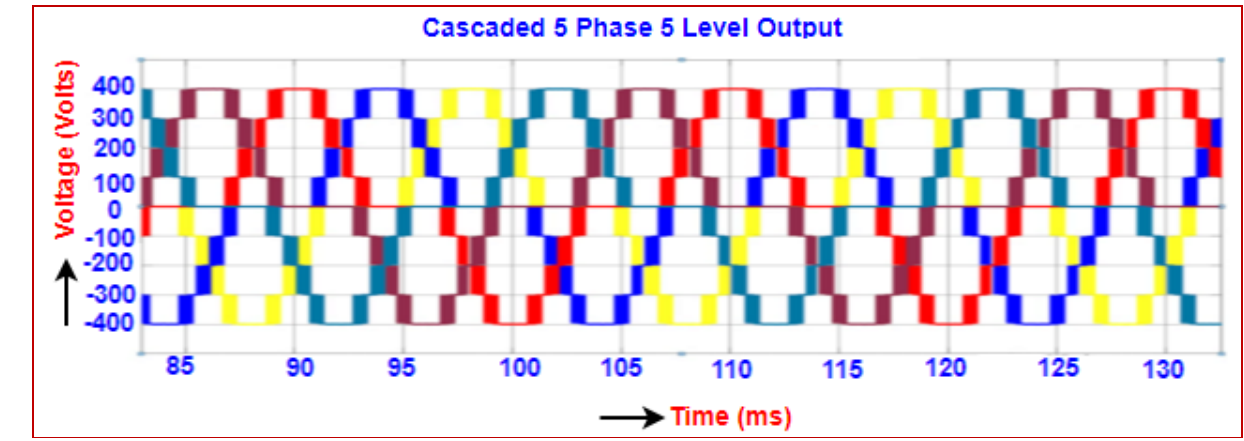
Figure 20. Output voltage of proposed reduced switch multilevel inverter.